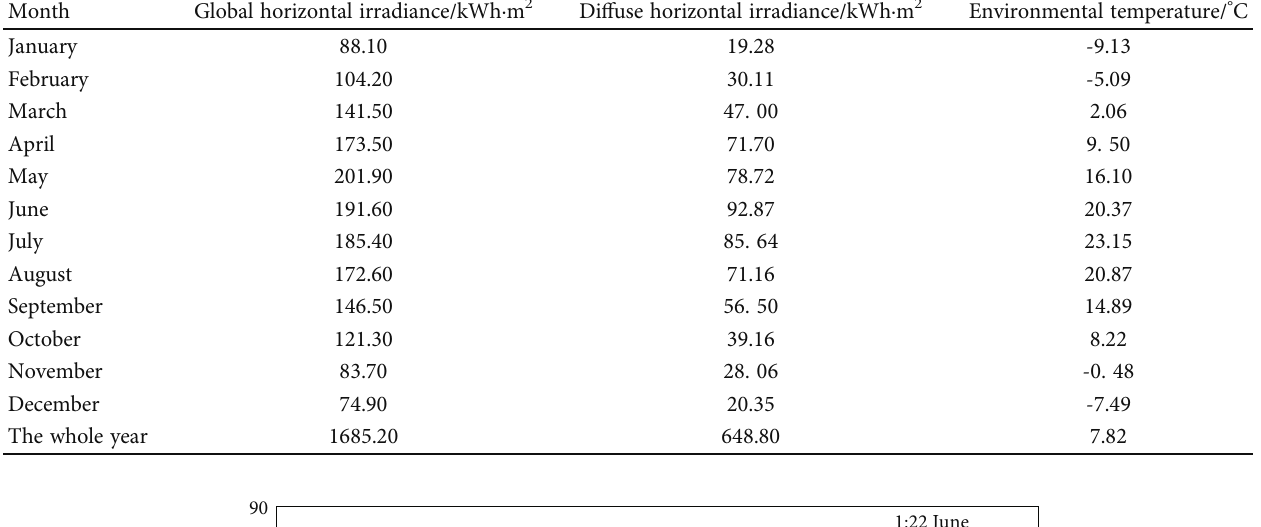
Table 4: Related meteorological data of Damaoqi, Baotou city.